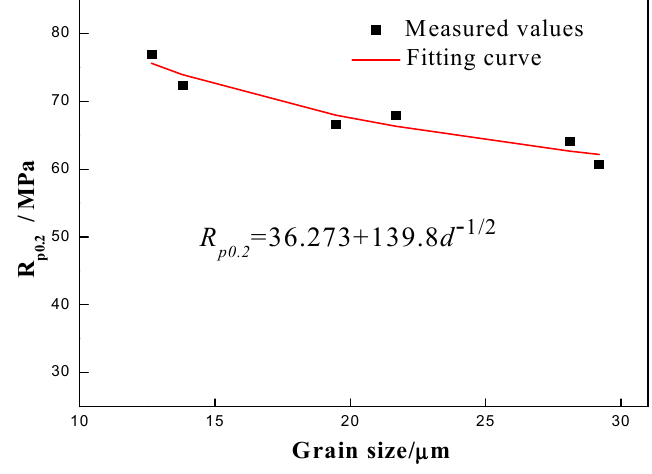
Figure 6. Relationship between grain size and yield strength and its fitting result.